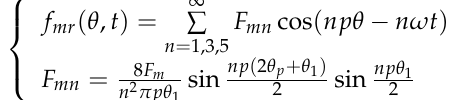
Figure 5. Permanent magnet magnetomotive force of AGE-IPMSM: ( a ) permanent magnetic field distribution and ( b ) permanent magnet MMF.